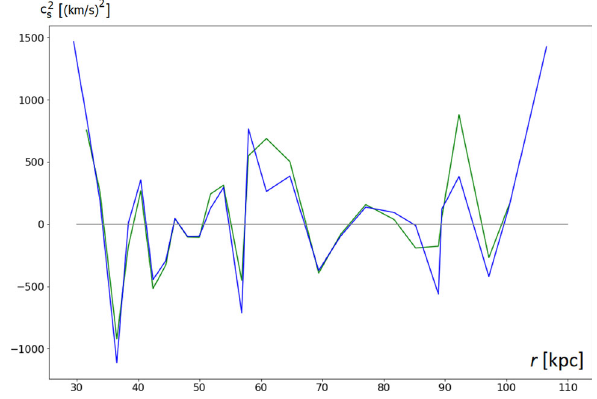
Fig. 7 Medians of c 2 s calculated using three-point (blue line) and five- point scheme (green line) for the calculation of derivatives, for the distance of Sun from the galactic center R 0 = 8 . 0 kpc and its